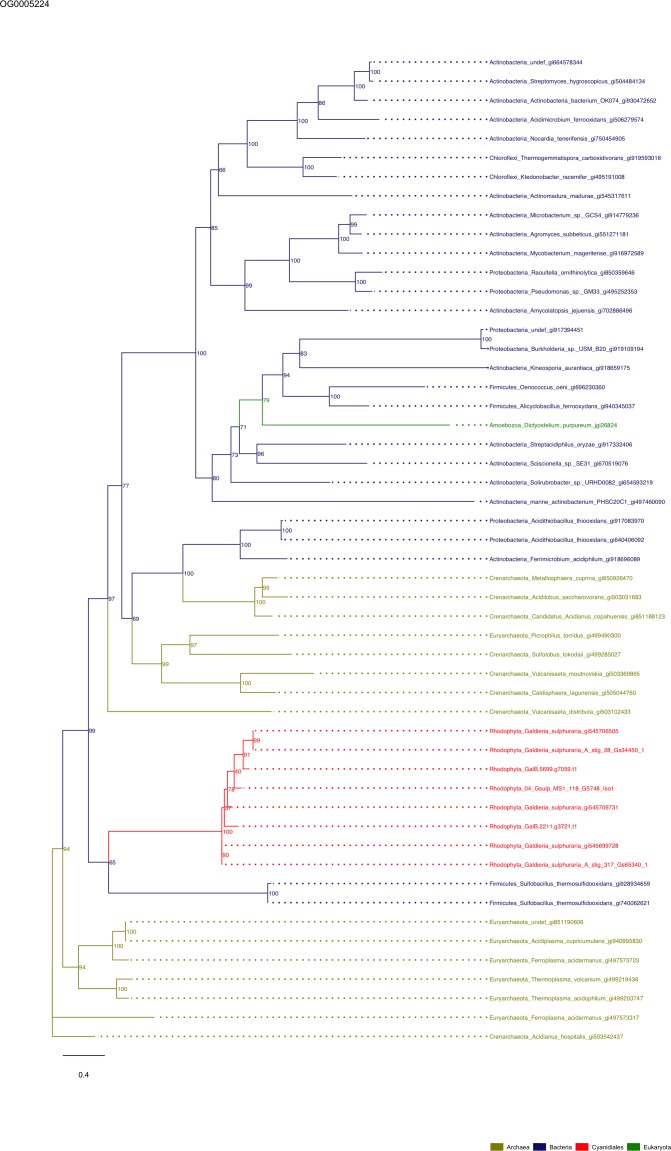
Sequence tree of orthogroup OG0005224.The tree is based on amino acid sequences. Archaea (yellow), Bacteria (blue), Cyanidiales (red), Eukaryotes including other red algae (green). Branches containing Cyanidiales sequences are highlited in red.